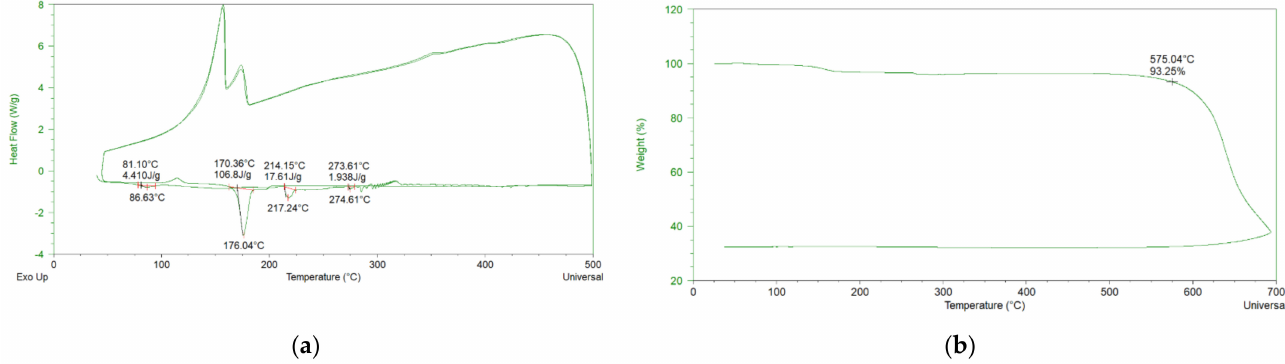
Figure 5. ( a ) 19% Ca (NO 3 ) 2 -46% NaNO 3 -35% LiNO 3 DSC curve, ( b ) 19% Ca (NO 3 ) 2 -46% NaNO 3 -35% LiNO 3 TGA curve.